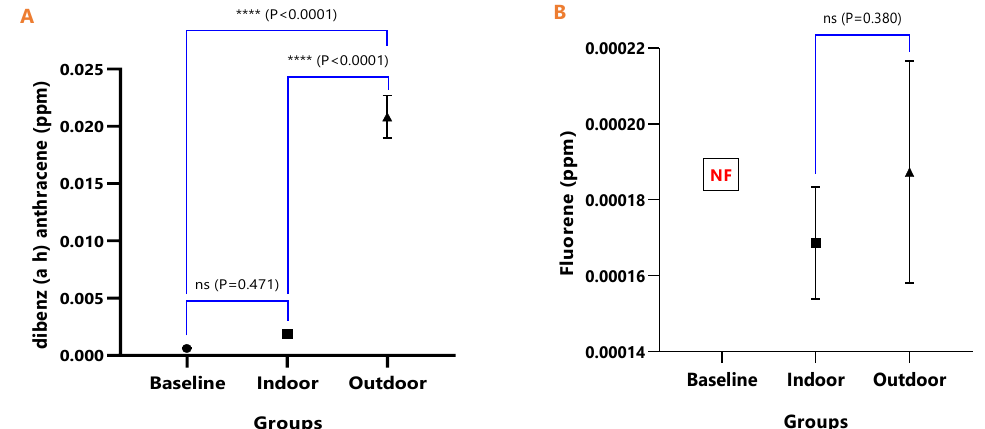
Figure 8. The mean concentrations and test of mean difference for ( A ) Dibenz (a h) anthracene and ( B ) Fluoranthene in the various animal groups.